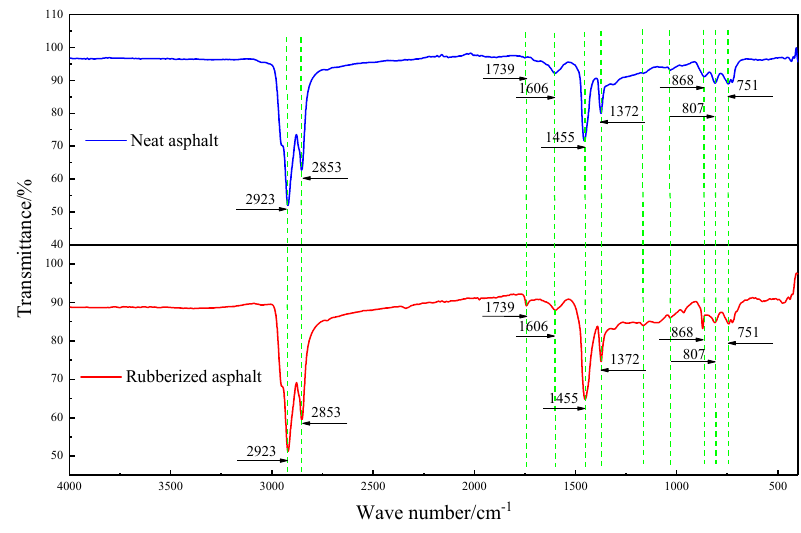
Figure 12. Modification mechanism of high-content rubberized asphalt.